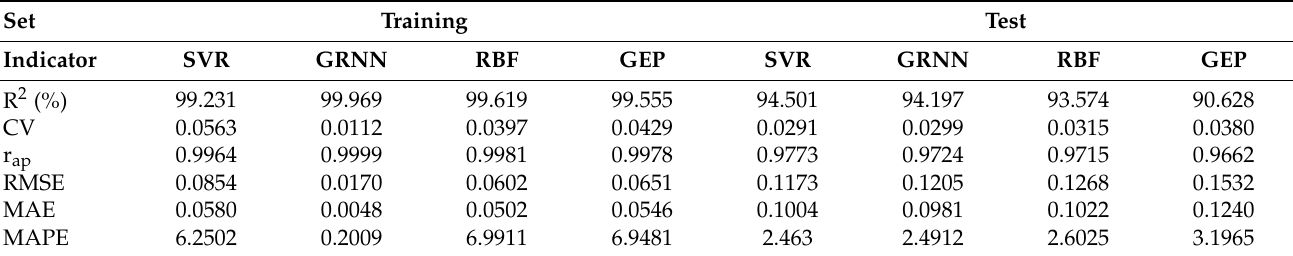
Table 3. The goodness of fit test for the brass sample mass loss in the cavitation field.